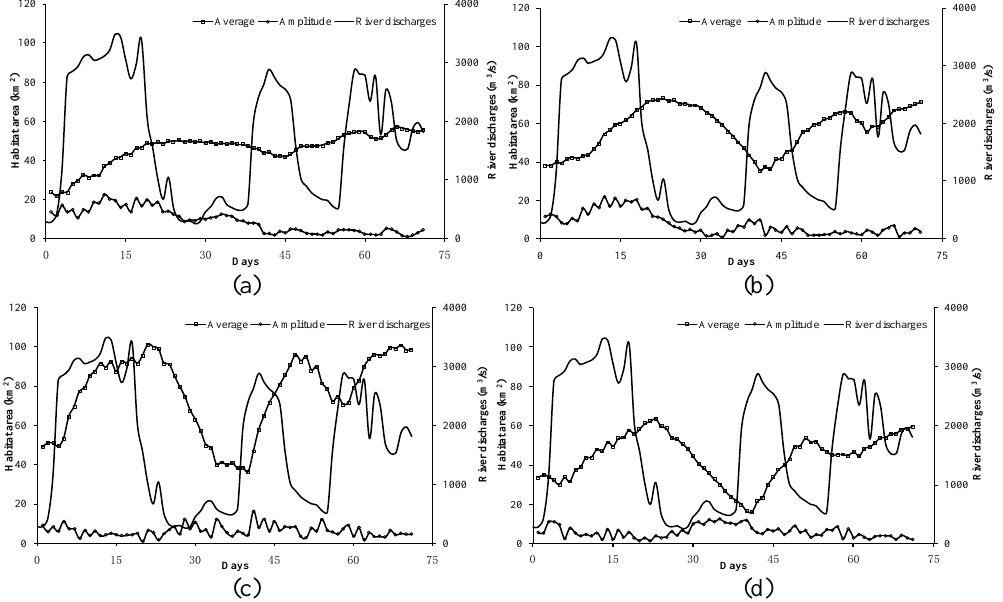
Fig. 8. Variations of habitat area with changes in river discharge. (a) Chinese shrimp; (b) ridgetail prawn; (c) Chinese mitten crab; (d)